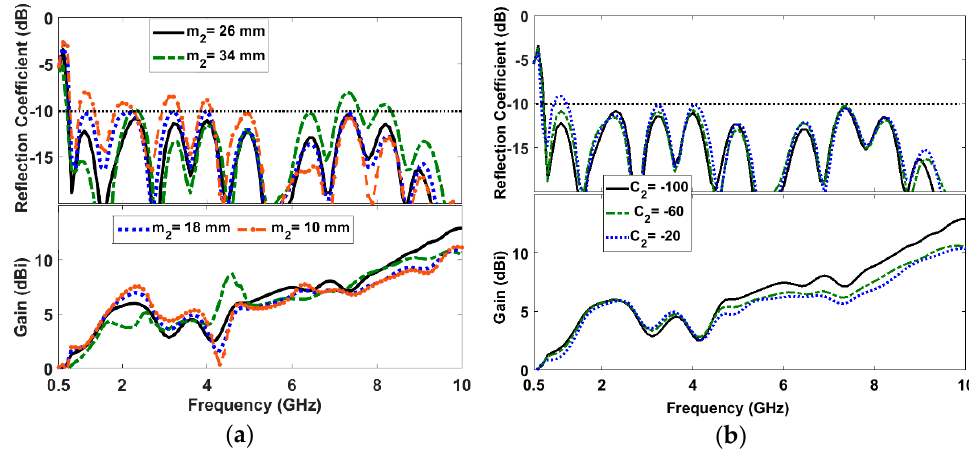
Figure 8. Reflection coefficient and antenna gain for (other parameters are constant) ( a ) different width and ( b ) the degree of exponential curve of the additional arms.